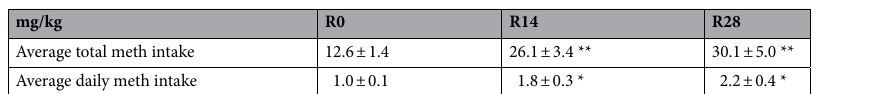
Table 2. Methamphetamine (meth) intake following 14 days of self-administration. One-way ANOVA with a post hoc Newman-Keuls, *p < 0.05, **p < 0.01 versus R0.